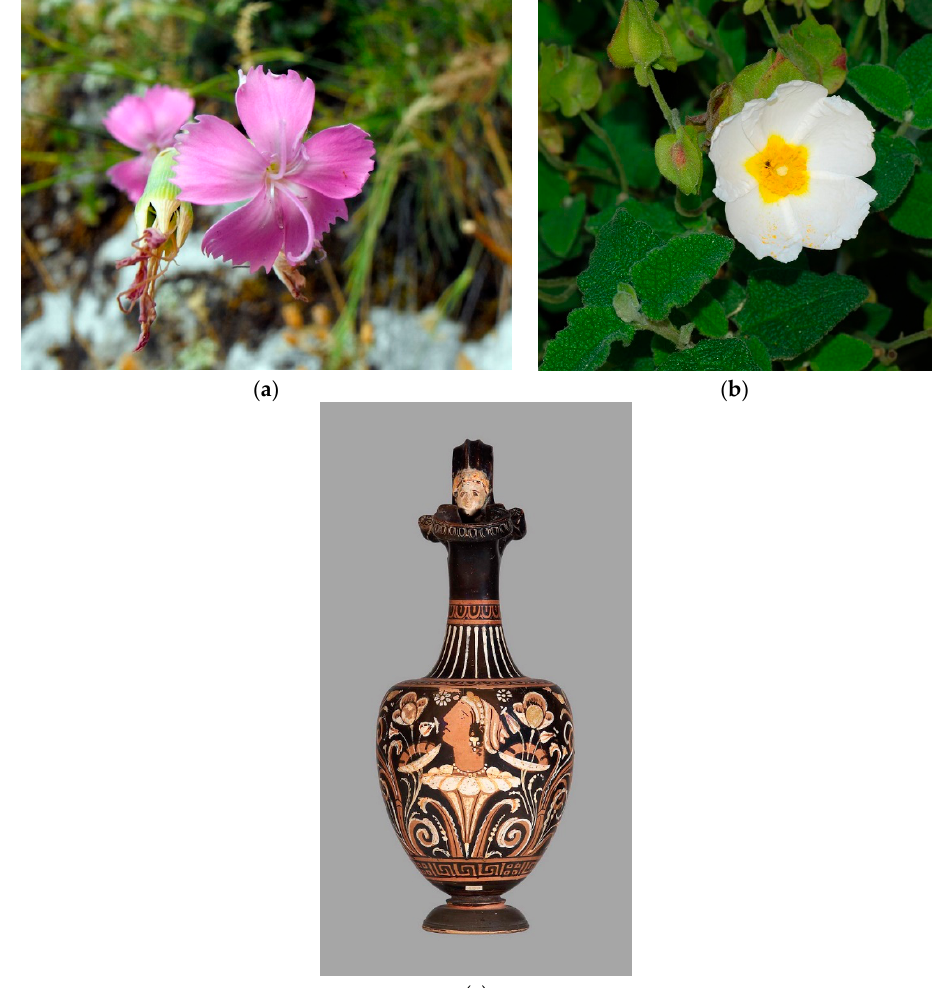
Figure 26. ( a ) Pinks ( Dianthus tarentium ). Photograph courtesy of Wikimedia Commons. ( b ) Sage-leaved rock rose ( Cistus salviifolius ). Photograph courtesy of Wikimedia Commons. ( c ) Boston, Museum of Fine Arts 76.54 Apulian oinochoe (type 1), close to or by the Baltimore Painter, ca. 330–320 B.C. Female head in profile to left emerging from flower flanked by floral tendrils. Photograph © Museum of Fine Arts, Boston.